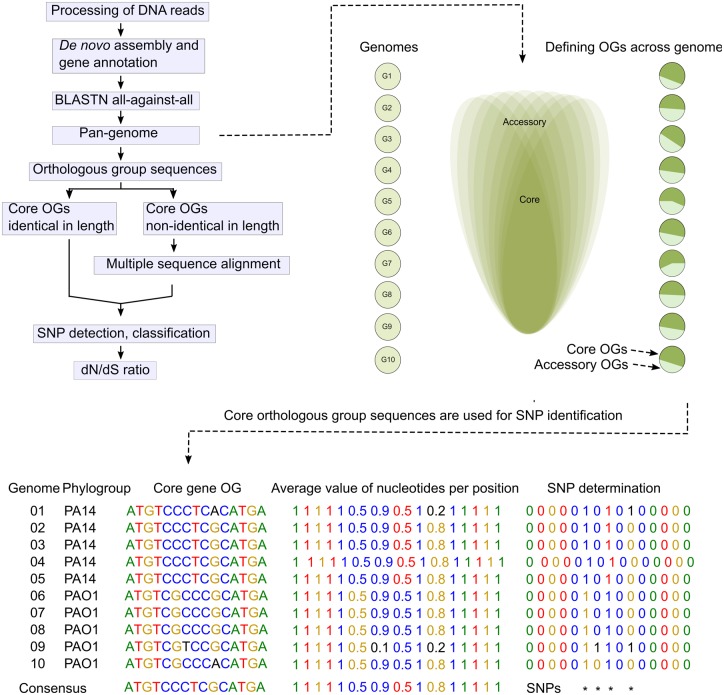
—Framework for SNP identification in the core genes. Raw DNA sequencing reads are processed and error corrected before de novo assembly and gene annotation. Orthologous groups (OGs) are identified based on an all-against-all sequence comparison of the genes in the assembled genomes. Each core gene orthologous group is aligned. The average value of each type of nucleotide at each position is calculated. Values are converted into 0s and 1s according to the most occurrences and least occurrences, respectively, and 1s are determined as sequence variations. Phylogroup information is further used to classify the divergent and convergent adaptation patterns.